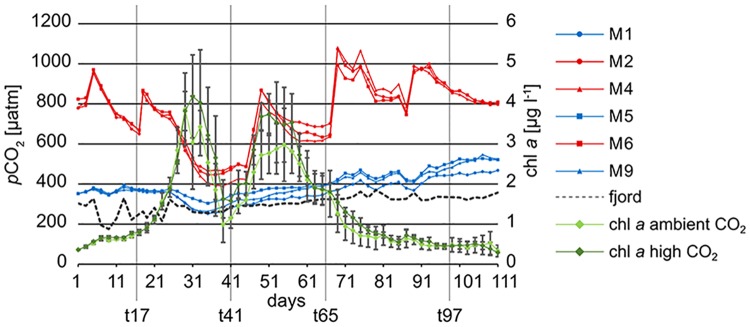
pCO2 and chlorophyll a concentration in mesocosms over the experimental period.High and ambient CO2 mesocosms are represented by red and blue lines, respectively. The fjord is indicated by a black dashed line. The mean chlorophyll a concentration in the selected high and ambient CO2 mesocosms is represented by a dark and light green line, respectively. X axis: experimental days. Left y axis: pCO2 concentrations. Right y axis: mean chlorophyll a concentrations. Data pooled from the three ambient and three high CO2 mesocosms, that were also used for the community barcoding. Error bars = SD.